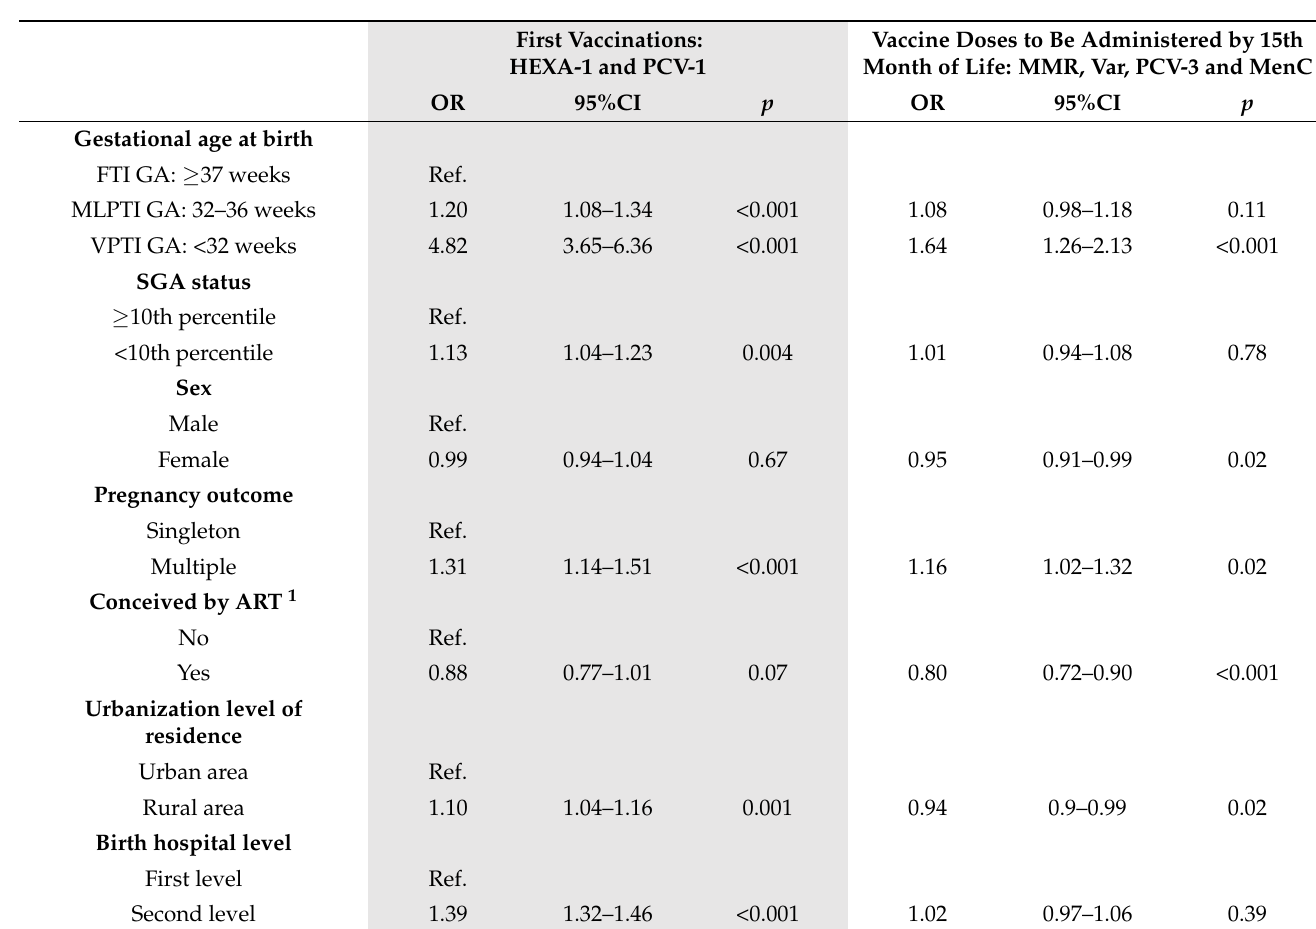
Figure 3. Forest plot reporting adjusted odds ratios (OR) of vaccination delay for preterm infants (compared to full-term infants) and SGA status (compared to infants who were not born SGA) for HEXA-1, HEXA-3, MMR, Var, MenC, PCV-1, and PCV-3 vaccine doses. * Reference: full-term infants GA ≥ 37 weeks; ** Reference: SGA ≥ 10th percentile. Table 4. Multivariate logistic regression models: determinants of delayed vaccination for first vaccinations (HEXA-1 and PCV-1) and for vaccine doses to be administered by 15th month of life (MMR, Var, PCV-3, and